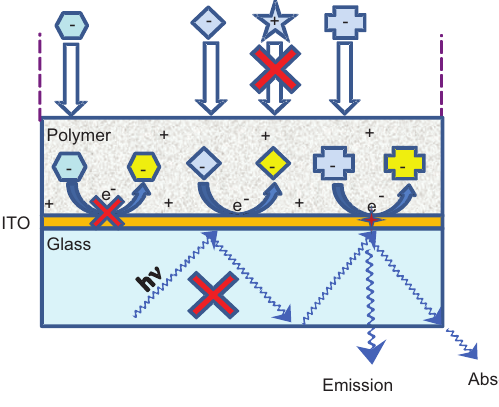
Figure 2 Schematic representation of a three component sensor and its operation. The polymer screens out analytes of dissimilar charge, the ITO layer discriminates among analytes based on their redox potential, and the transmitted light activates analytes based on their